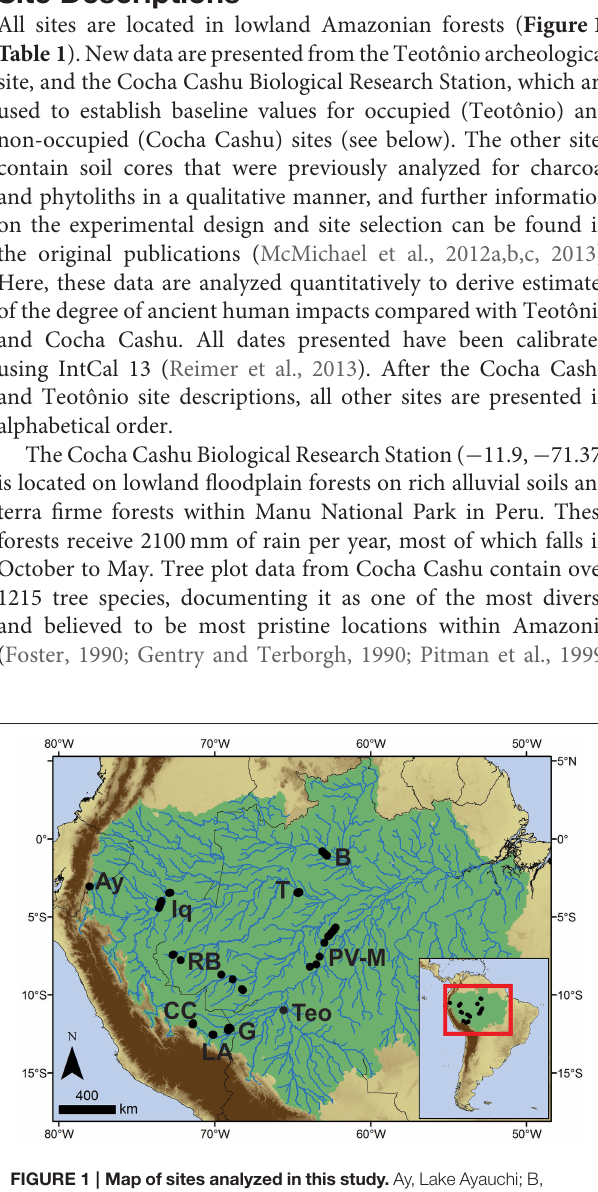
FIGURE 1 | Map of sites analyzed in this study. Ay, Lake Ayauchi; B, Barcelos; CC, Cocha Cashu; G, Lake Gentry; Iq, Iquitos; LA, Los Amigos; PV-M,PortoVelho–Manaus;RB,RioBranco;T,Tefe;Teo,Teotônio.Amazoniais outlined in